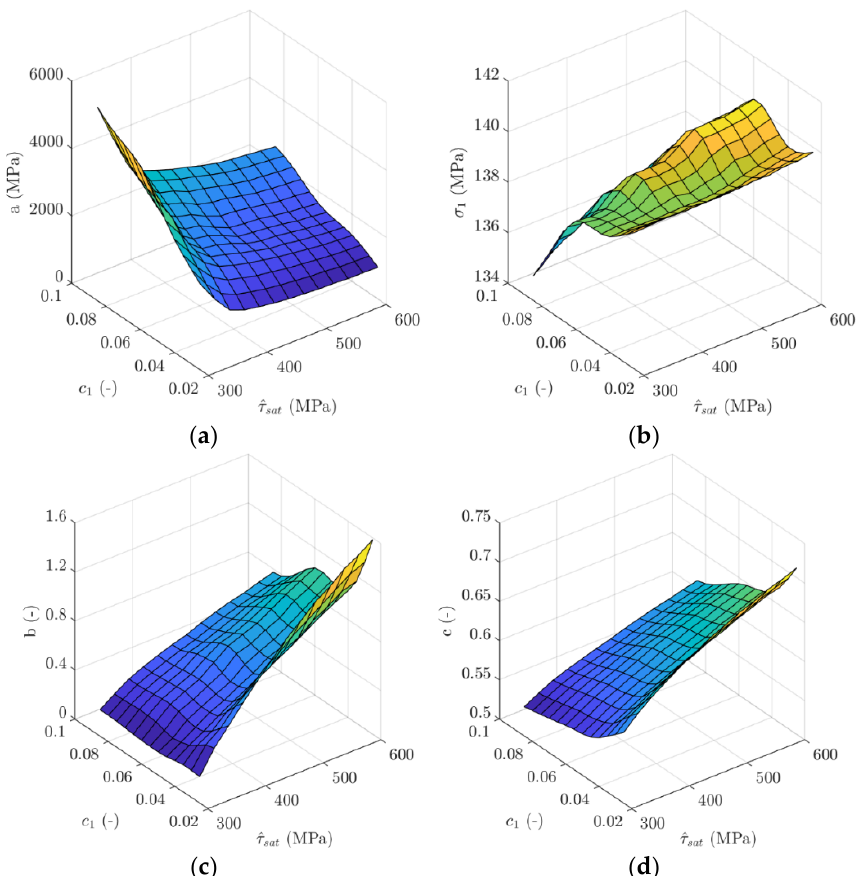
Figure 13. Comparison between numerical results and fitted curves with change in both τ (cid:3548) sat and c 1 .